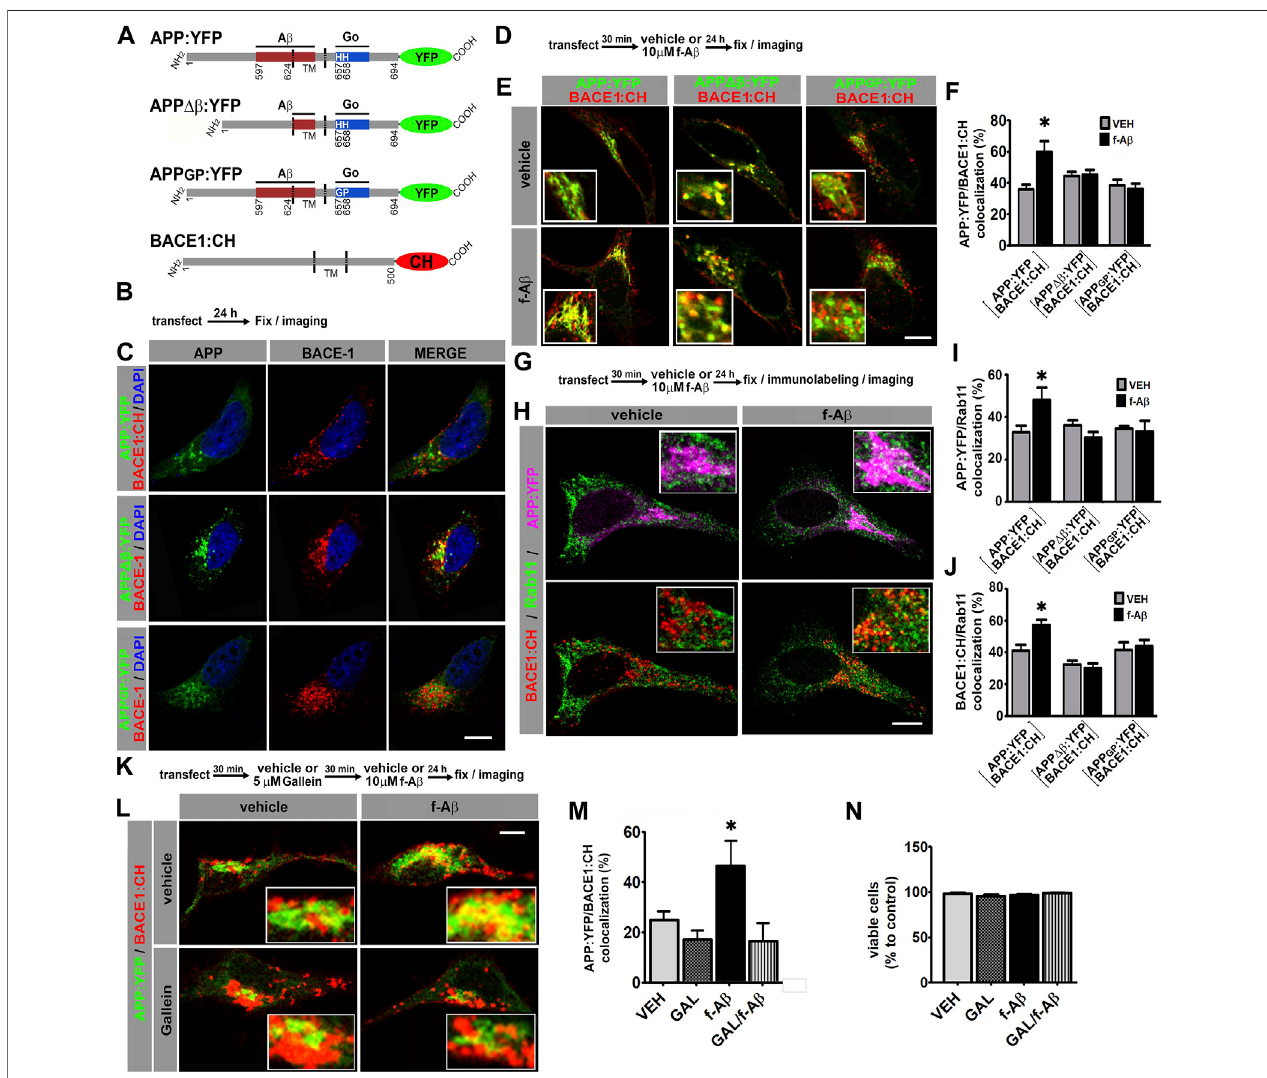
FIGURE 1 | Fibrillar A β increases colocalization of APP:YFP and BACE1:CH in recycling endosomes through Go/G βγ -dependent signaling in HeLa and N2a cells. (A) . Schematic illustration of variants of APP695 fused to YFP and BACE1 fused to CH. A β and Go protein-interacting domains are indicated as red and blue boxes, respectively.AminoacidnumberingforAPPandBACE1areindicated.TM,transmembranedomain. (B) .ExperimentaldiagramforC. (C) .ConfocalimagesofHeLacells co-expressingtheindicatedproteins. (D) .ExperimentaldiagramforEandF. (E) .ConfocalimagesofHeLacellsco-expressingtheindicatedproteins. (F) .Manders coef fi cients of colocalization of APP:YFP, APP Δ β :YFP, or APPGP:YFP and BACE1:CH expressed as percent (n = 56 between 8 and 11 cells for each condition) *: p ≤ 0.001 vs. VEH by ANOVA followed by LSD post-hoc test. (G) . Experimental diagram for H-J. (H) . Confocal images of HeLa cells co-transfected with the indicated proteinsandimmunolabeledwithantibodyagainstRab11followedbyAlexaFluor633-conjugatedantirabbitantibody.UpperpanelshowspseudocolorimagesforAPP: YFP (magenta) and Rab11(green),and lower panel forBACE1:CH (red) and Rab11 (green). (I) . Manders coef fi cients ofcolocalization ofAPP:YFP and Rab11 expressed aspercent(n=62between8and11cellsforeachcondition)*: p ≤ 0.005vs.VEHbyANOVAfollowedbyLSD post-hoc test. (J) .Manderscoef fi cientsofcolocalizationof BACE1:CH and Rab11 expressed as percent (n = 62; between 8 and11 cells for each condition) * p = 0.001 vs. VEH by ANOVA followed by LSD post-hoc test. (K) . Experimental diagram for L-N. (L) . Confocal images of N2a cells co-expressing the indicated proteins. (M) . Manders coef fi cients of colocalization of APP:YFP and BACE1:CHexpressed aspercent(n=29;between7and8cellsforeach condition)*: p =0.004vs.GAL+f-A β and p =0.031vs.VEHbyANOVAfollowedbyLSD post- hoc test. (N) . Quantitative analysis of viable cells expressed as percent of control (n = 27, between 6 and 7 cells for each condition). In all cases, data represent mean ± SEM. Scale bar is 10 μ m. VEH: vehicle (control); f-A β : fi brillar A β 1-42; Gal: gallein. Inserts are ×2.5 enlargement of the corresponding image.